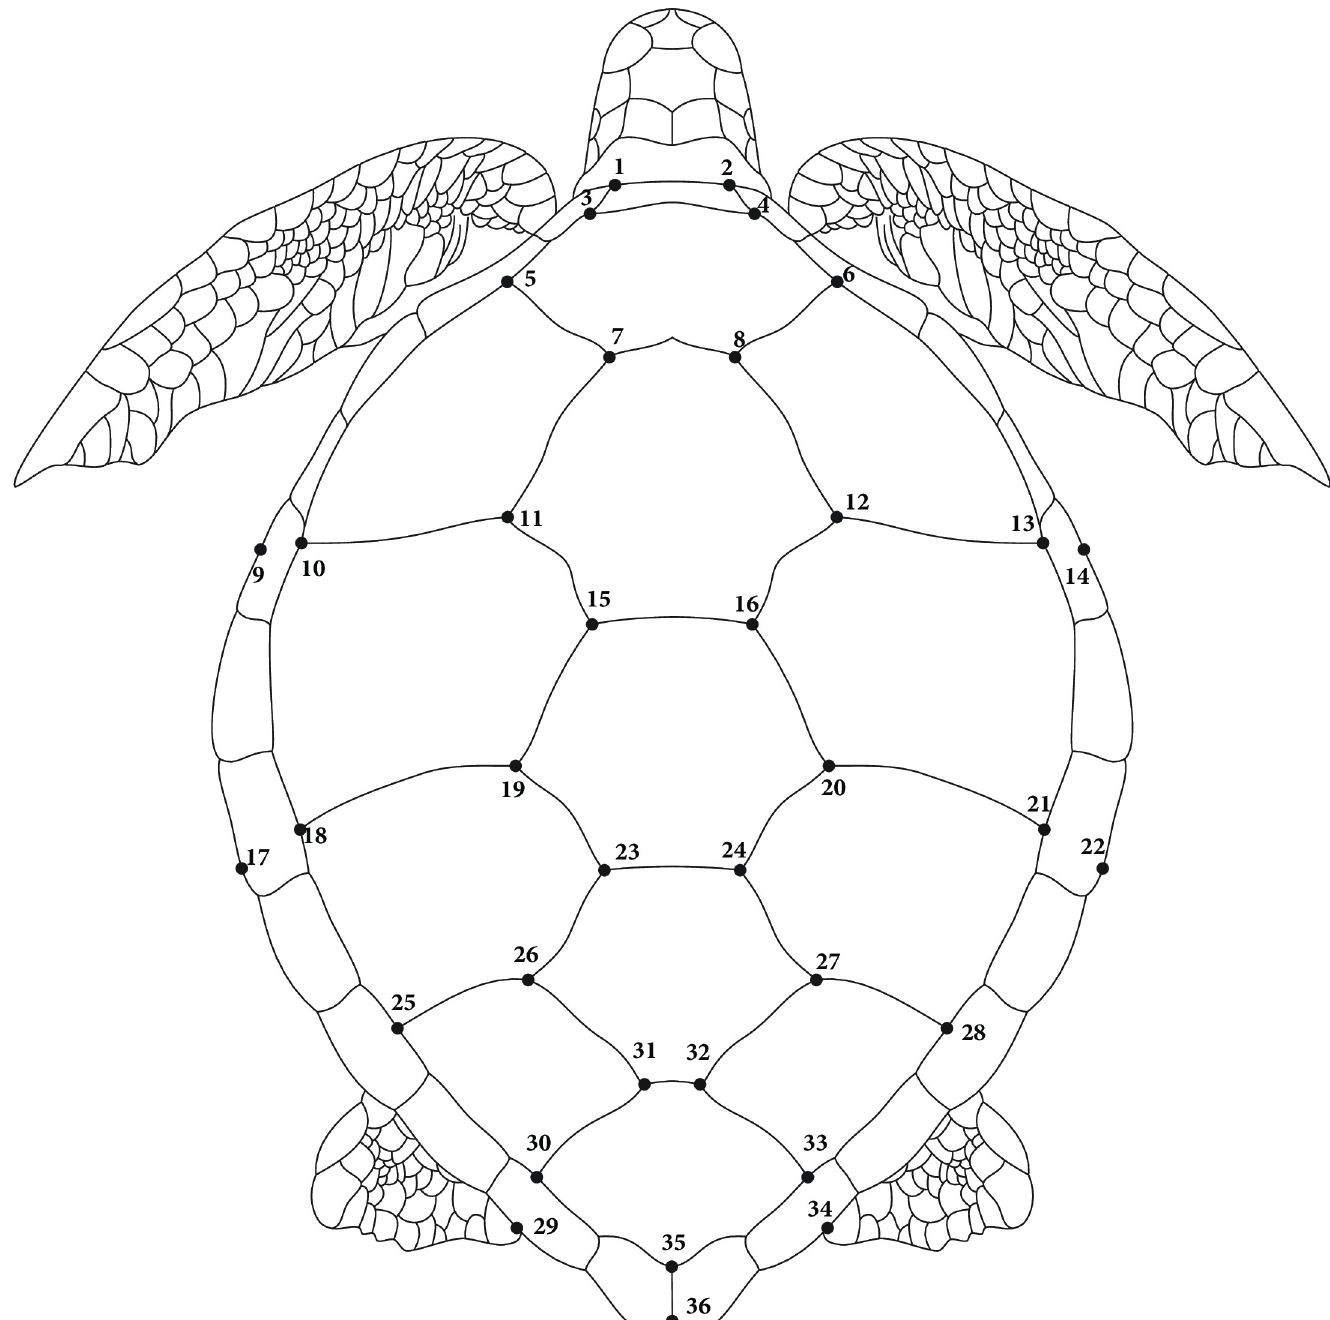
Fig 1. Representation of the 36 landmarks identified on Chelonia mydas